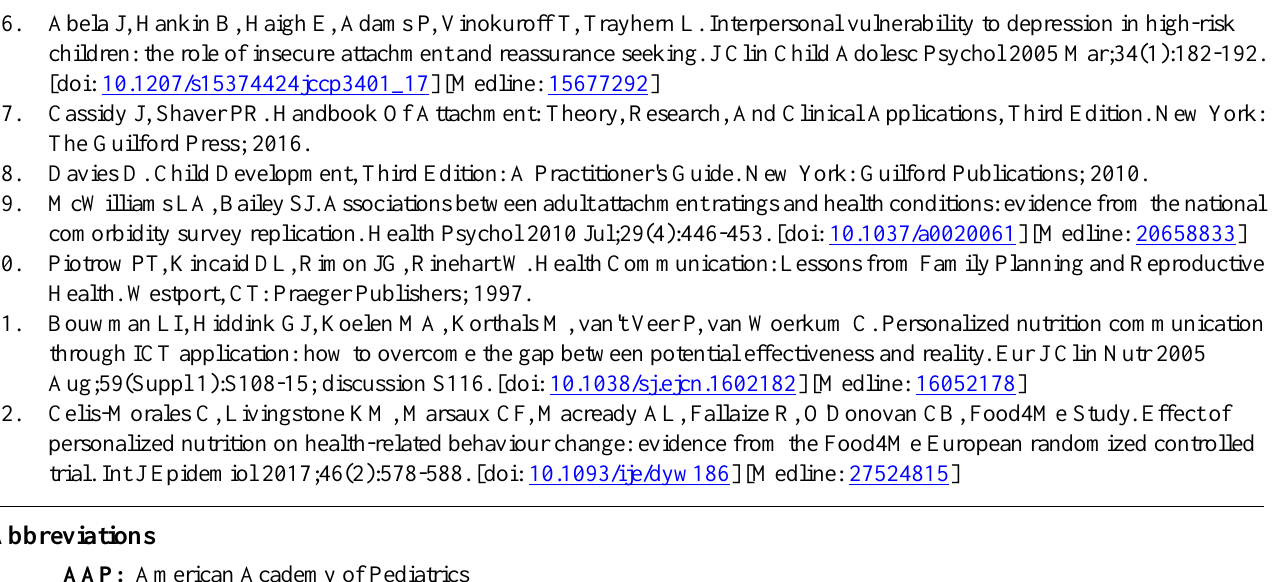
Abbreviations AAP: American Academy of Pediatrics CRM: customer relationship management DDI: data-driven innovation HCP: health care